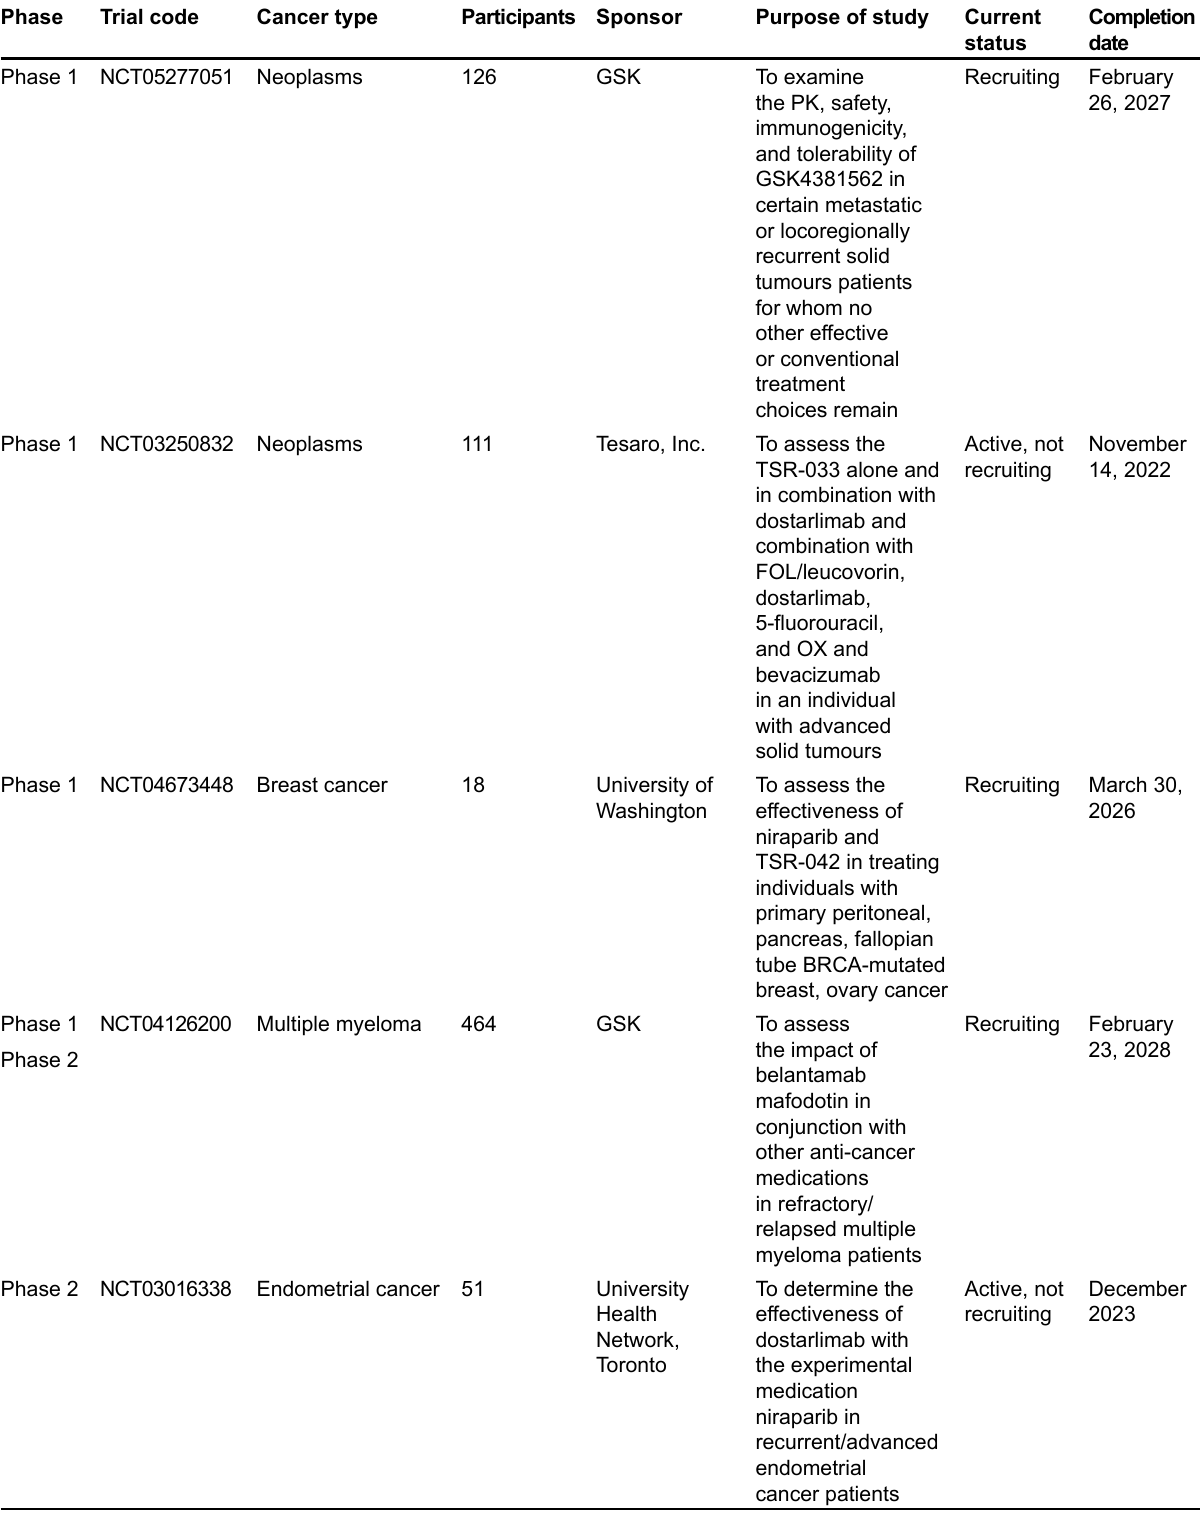
Table 2. Trials of dostarlimab ( continued )